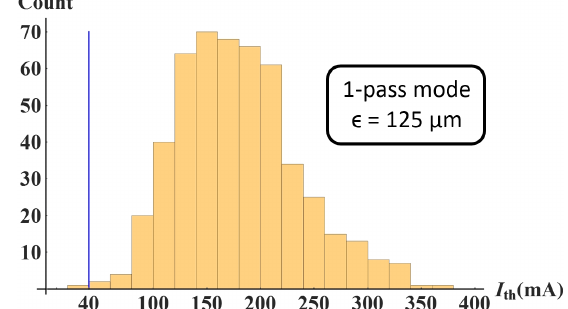
FIG. 3. 500 BBU simulation results of I 1-pass lattice. Each cavity is assigned with a random set of 10 dipole HOMs ( ϵ ¼ 125 μ m). The blue line indicates the higher current goal of 40 mA.